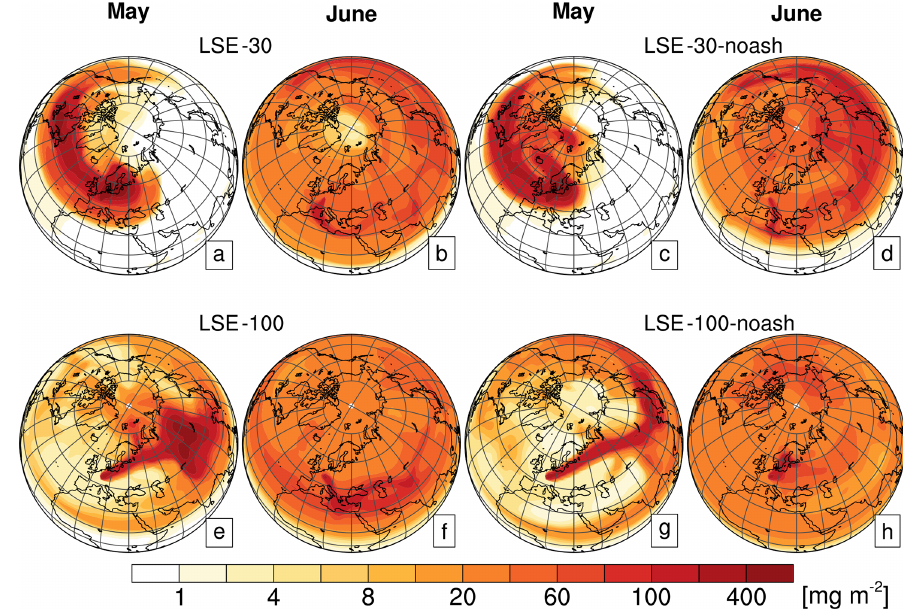
Figure 6. Monthly mean sulfur burden (SO 2 plus sulfate [mg(S)m − 2 ]) with (a, b, e, f) and without (c, d, g, h) the injection of ash. The burden is averaged over May and June for the LSE-30, LSE-100, LSE-30-noash and LSE-100-noash scenarios with the same eruption rate but different injection altitudes (30hPa, a–d ; 100hPa, e–h ).